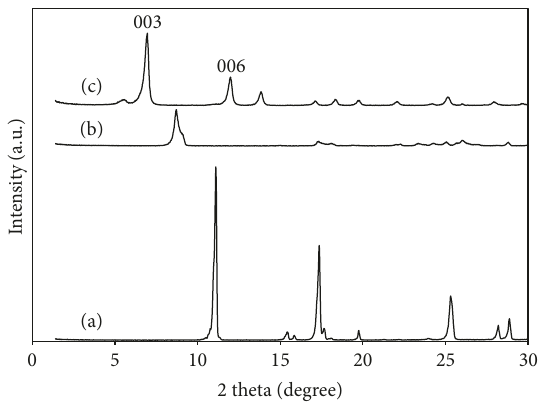
Figure 1: X-ray diffraction patterns: (a) salicylic acid, (b) zinc hydroxide nitrate (ZHN), and (c) zinc hydroxide nitrate intercalated by the anion salicylate (LHS (salicylate)).